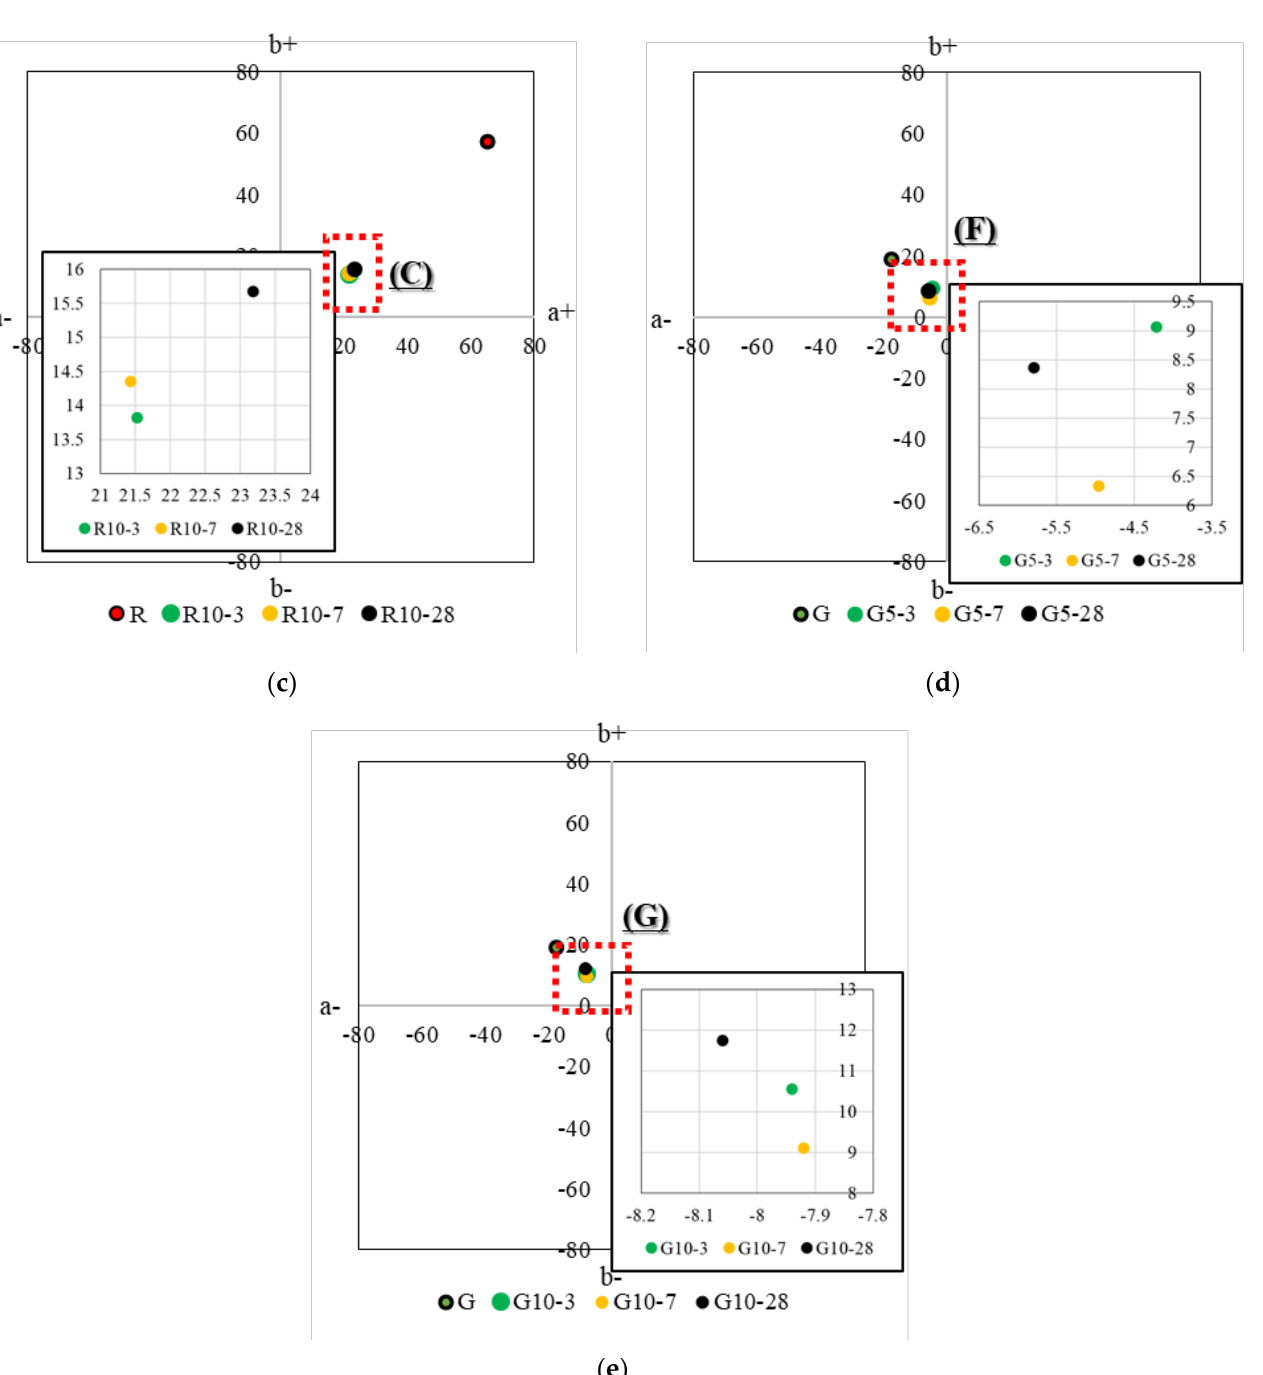
Figure 8. CIELAB analysis of HSCCs. The average coordinates of color measurement from (1) to (9) are presented in Figure 7. ( a ) Average value of the color-measurement section of specimen P at each age, ( b ) average value of the color-measurement section of specimen R5 at each age, ( c ) average value of the color-measurement section of specimen R10 at each age, ( d ) average value of the color-measurement section of specimen G5 at each age, and ( e ) average value of the color-measurement section of specimen G10 at each age.